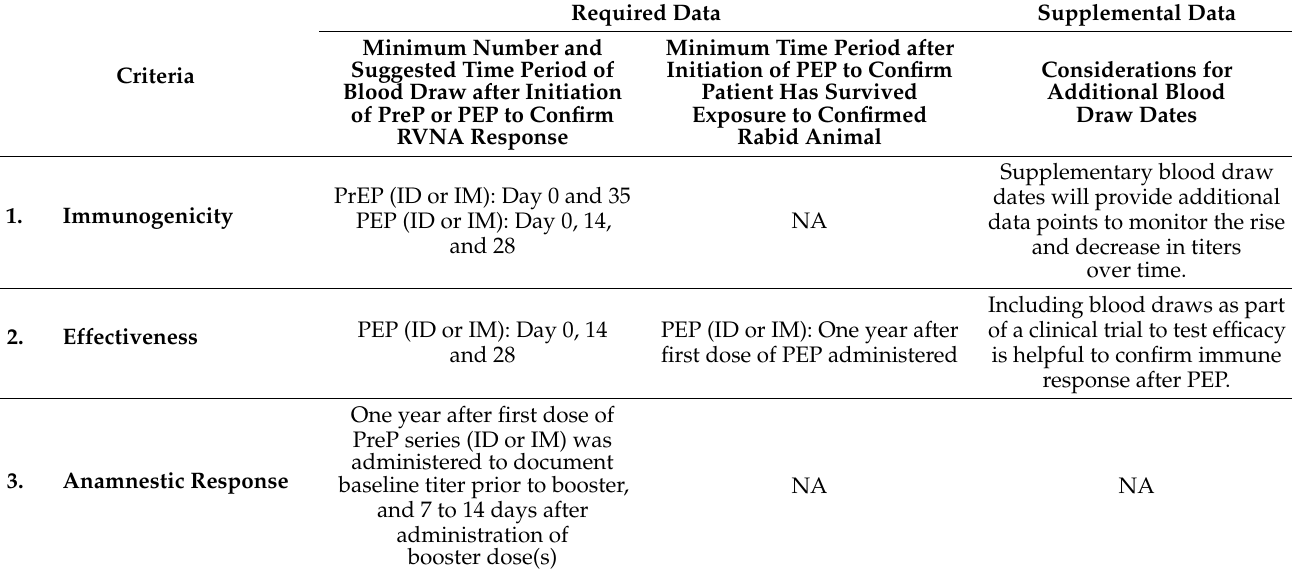
Table 1. Immunogenicity, efficacy, and anamnestic response. Suggested minimum number of blood draws required to confirm proof of immunogenicity after intramuscular (IM) or intradermal (ID) post-exposure prophylaxis (PEP) or pre-exposure vaccination (PreP); suggested confirmatory evidence of protection against rabies after proven exposure to rabies; and suggested proof of an anamnestic response after booster in persons that have previously received PreP by either IM or ID route. Rabies virus neutralizing antibody (RVNA) levels should be evaluated using a validated RVNA assay. NA refers to